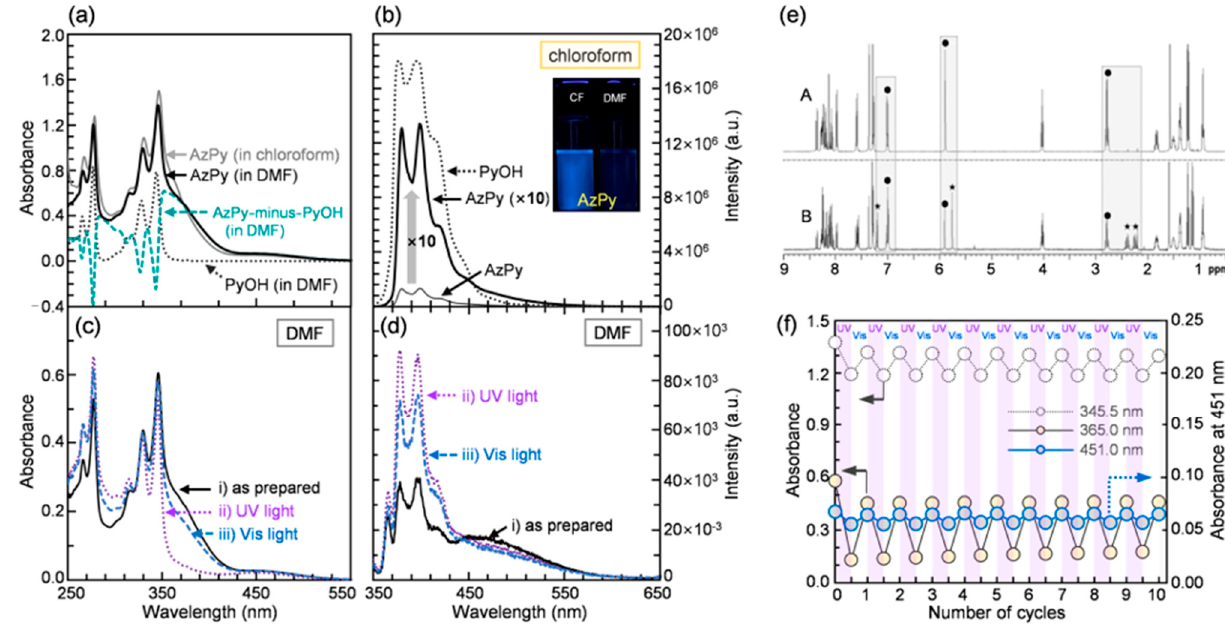
Figure 1. UV ‐ vis absorption and fluorescence spectra of AzPy and PyOH in chloroform and DMF. ( a ) Absorption (20 μ M) and ( b ) fluorescence spectra, emission under UV light irradiation (inset). ( c ) Absorption and ( d ) fluorescence ( λ ex = 330 nm) spectral changes of AzPy in DMF (10 μ M) after UV (at 365 nm, ~1.0 mW/cm 2 ) and subsequent visible (at 436 nm, ~1.0 mW/cm 2 ) light irradiation. ( e ) 1 H NMR spectral changes in CDCl 3 . ( A ) As ‐ prepared (all trans form). ( B ) After UV light irradiation for 90 min ( trans / cis ≈ 30/70). ( f ) Changes in the absorbances at 345, 365, and 451 nm upon alternating irradiation with UV and visible light.